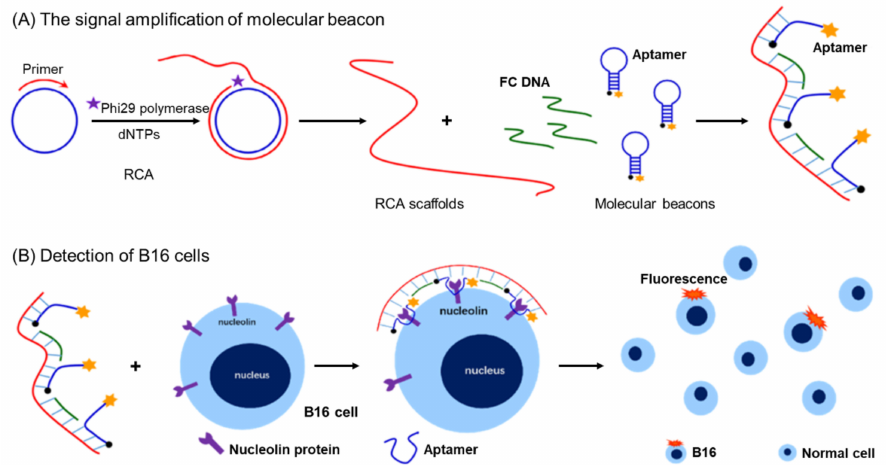
Figure 14. ( A ) Construction of a multivalent binding scaffold using the rolling circle amplification (RCA), fixed complementary (FC) DNAs, and molecular beacon-type aptamers. ( B ) Detection of B16 cells using the designed multivalent binding scaffolds. Adapted with permission from ACS Biomater. Sci. Eng. 2020, 6, 3114–3121, doi:10.1021/acsbiomaterials.0c00288. Copyright (2020) American Chemical Society